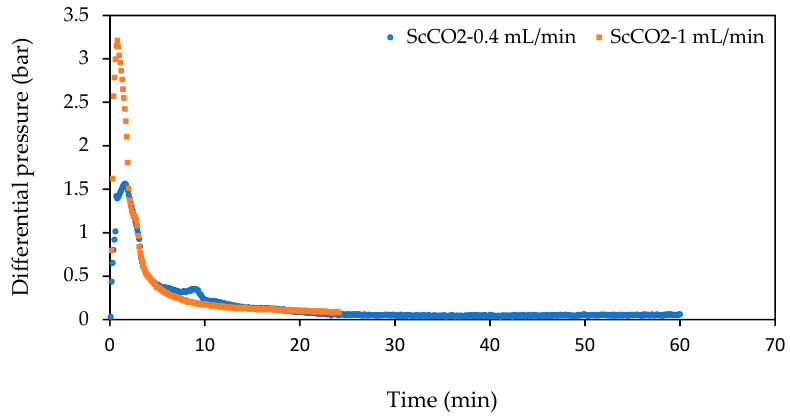
Figure 15. Effect of injection rate on the differential pressure profile of LCO 2 –oil displacements conducted at 70 bar and 20 °C.